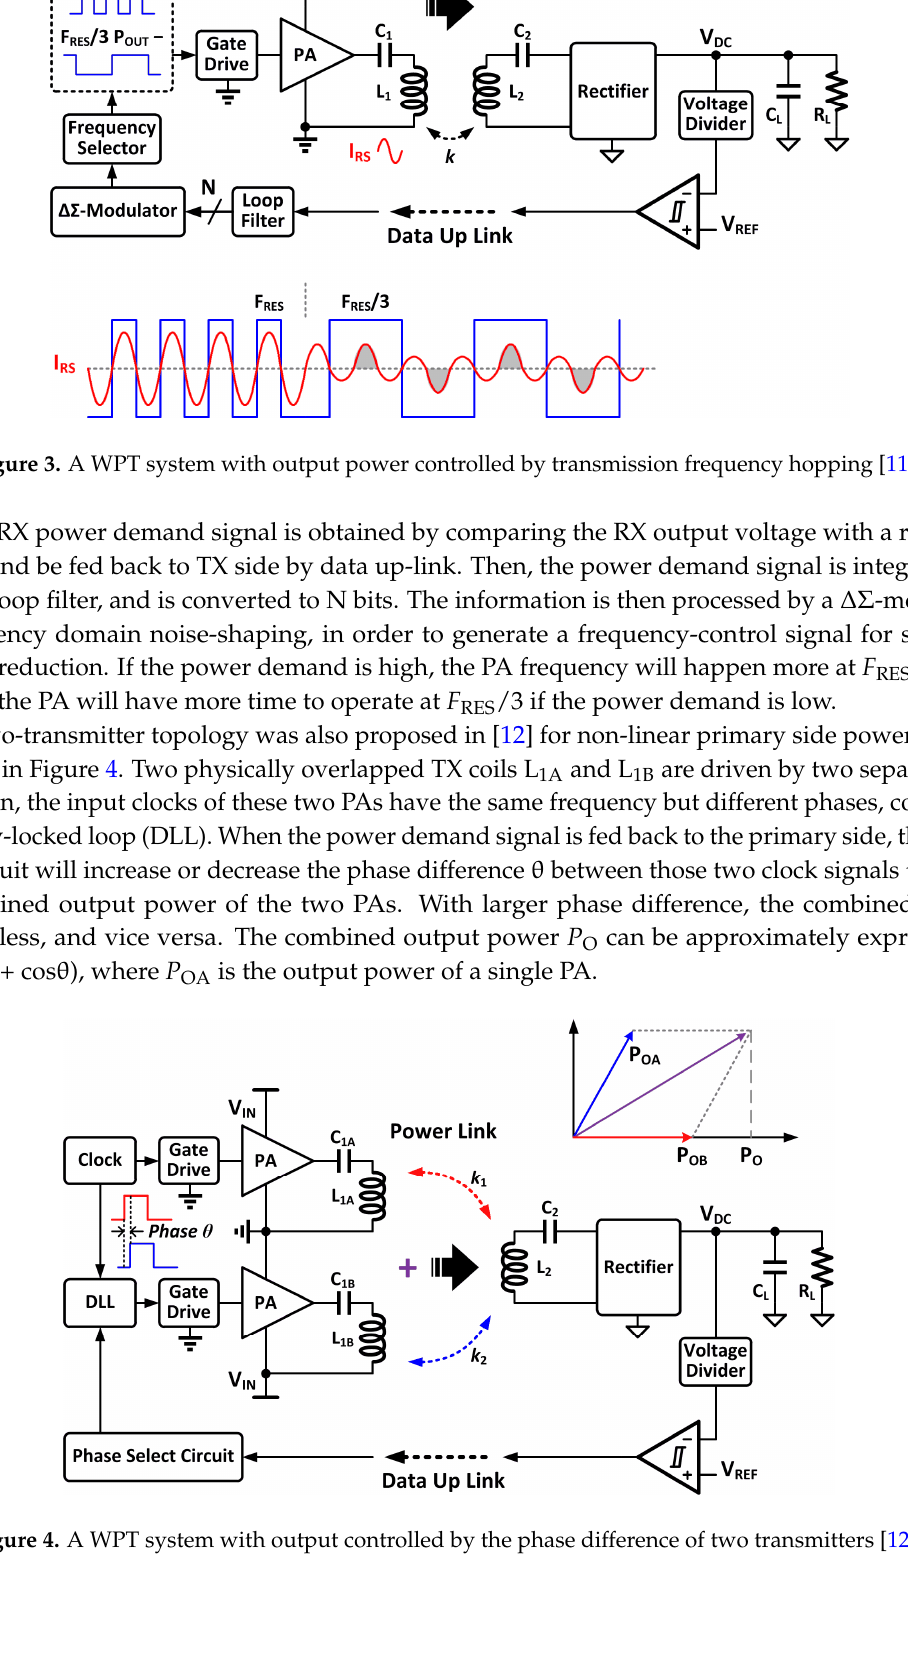
Figure 4. A WPT system with output controlled by the phase difference of two transmitters [12].